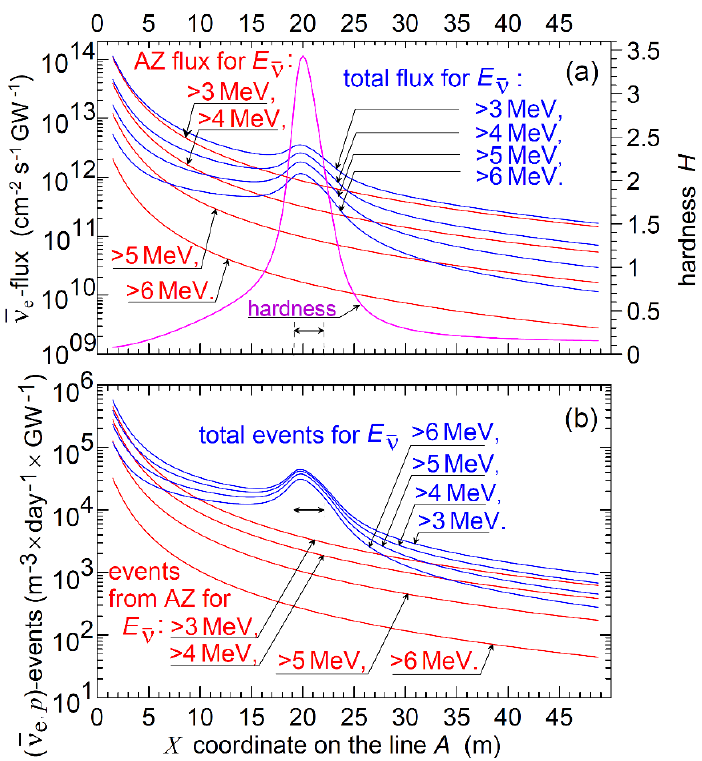
Figure 4 . The expected antineutrino (cid:13)uxes (part (a)) and number of ((cid:22) (cid:23) e , p )-events (part (b)) in the detector depending on the X coordinates along the line A (geometry of (cid:12)gure 3). The results are given for thresholds of registration: 3, 4, 5, and 6 MeV. The total (cid:13)uxes and total number of events is ensured by (cid:22) (cid:23) e from 8 Li and AZ (Active Zone). Close to the reservoir position (given by the two-sided arrow) we can see sharp rise of hardness H (lithum bump) for total (cid:22) (cid:23) e -spectrum (see part